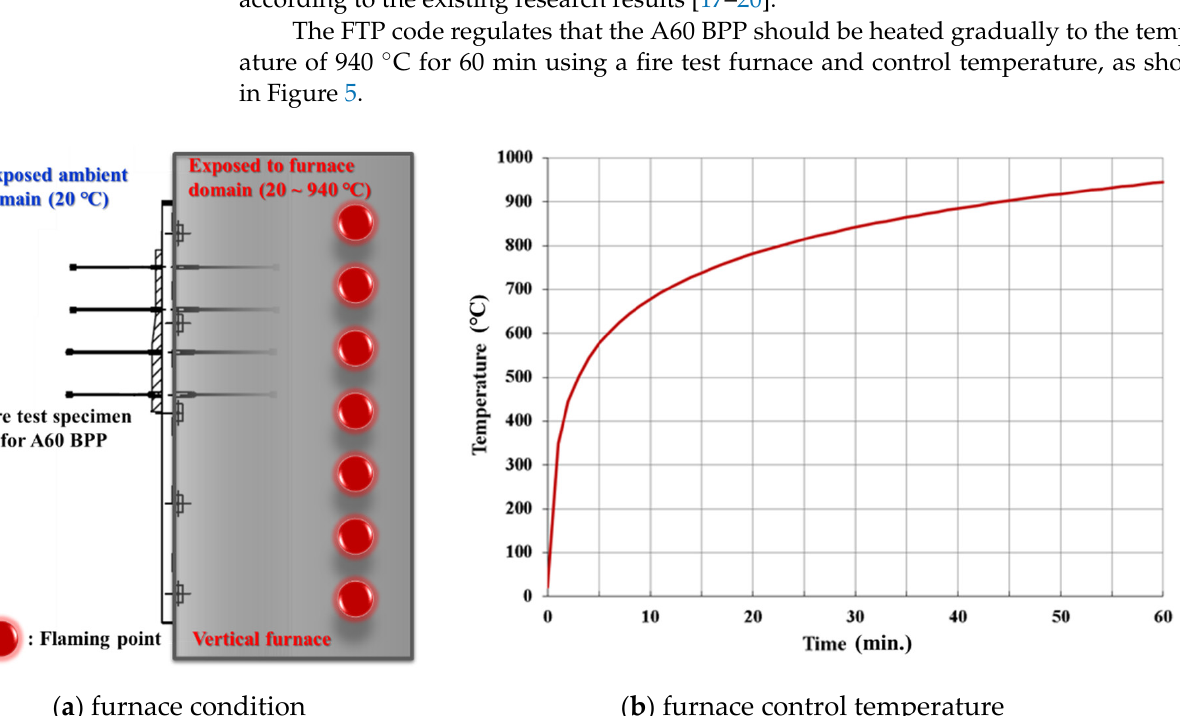
Figure 5. Fire test furnace condition.